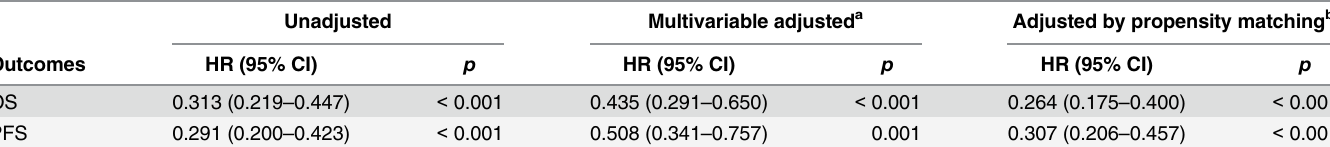
Table 4. Hazard ratio (HR) for clinical outcomes in the AFP responder group compared with the AFP non-responder group. Unadjusted Multivariable adjusted a Adjusted by propensity matching